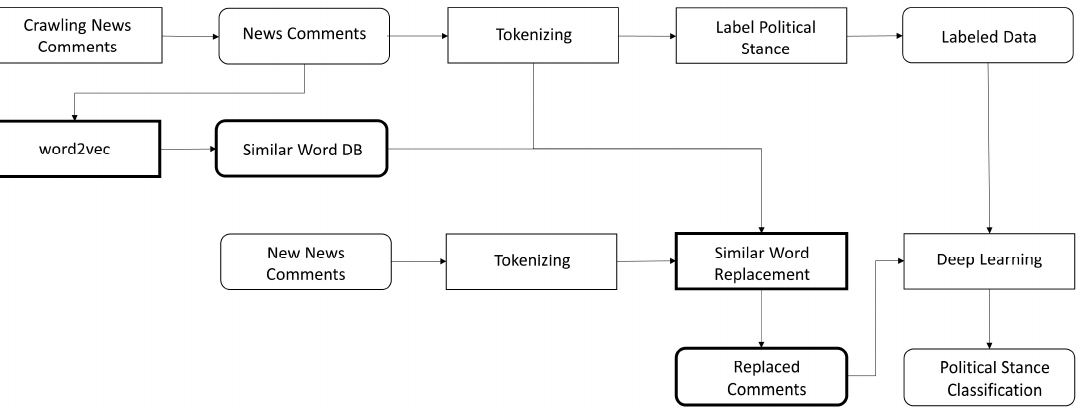
Figure 4. Political Stance Classification using SWR.